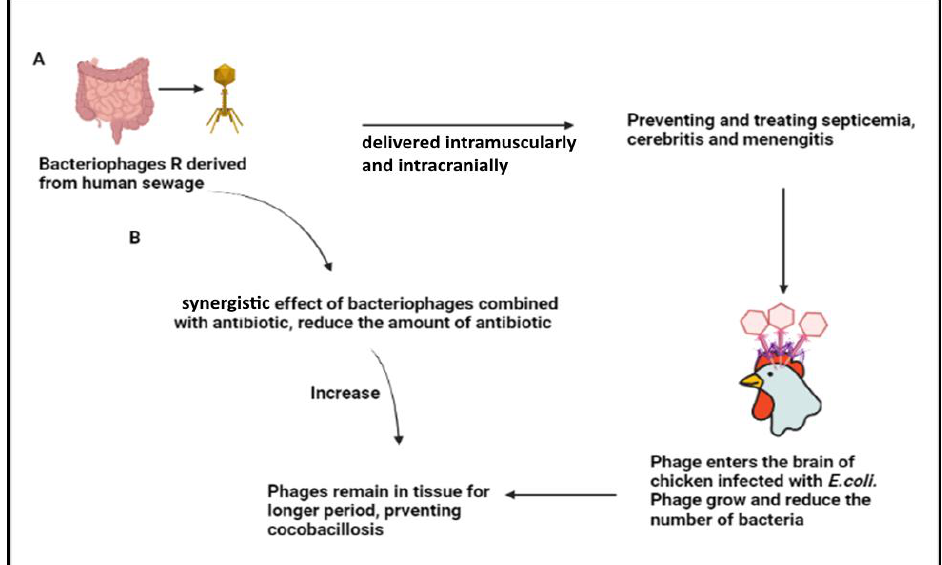
Figure 5. ( A ) Bacteriophages R derived from human sewage delivered intramuscularly and intra- cranially that prevent and treat septicemia, cerebritis, and meningitis. Phage enters the brain of in- fected chicken, reducing the number of bacteria, and remaining within the tissue for a longer period, thus preventing colibacillosis. ( B ) shows the synergistic effects of bacteriophages with an antibiotic, which increases the prevention of colibacillosis.